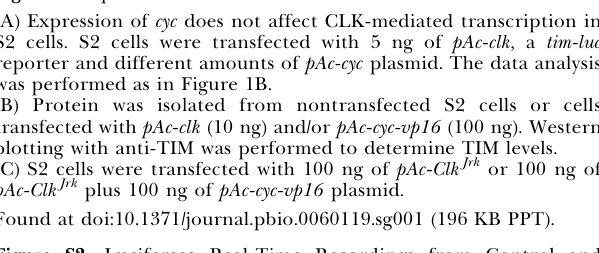
Figure S1. Specific Effects of CYCVP16 in S2 Cells (A) Expression of cyc does not affect CLK-mediated transcription in S2 cells. S2 cells were transfected with 5 ng of pAc - clk , a tim - luc reporter and different amounts of pAc - cyc plasmid. The data analysis was performed as in Figure 1B. (B) Protein was isolated from nontransfected S2 cells or cells transfected with pAc - clk (10 ng) and/or pAc - cyc - vp16 (100 ng). Western blotting with anti-TIM was performed to determine TIM levels. (C) S2 cells were transfected with 100 ng of pAc - Clk Jrk or 100 ng of pAc - Clk Jrk plus 100 ng of pAc - cyc - vp16 plasmid. Found at doi:10.1371/journal.pbio.0060119.sg001 (196 KB PPT). Figure S2. Luciferase Real-Time Recordings from Control and tim - cyc - vp16 Flies (A) Luciferase recordings from whole flies for the different fly strains were performed as described in the Materials and Methods section. (B) Each of the curves in (A) (fly wing Luciferase recordings) was normalized to its maximum value and then plotted together. In the lower right box, an amplification of the marked region is shown. Figure S3. Representation of the Period Spread among Individuals of Different Fly Strains The y -axis corresponds to the relative frequency. The dataset is identical to that displayed in Figure 7A. Found at doi:10.1371/journal.pbio.0060119.sg003 (166 KB